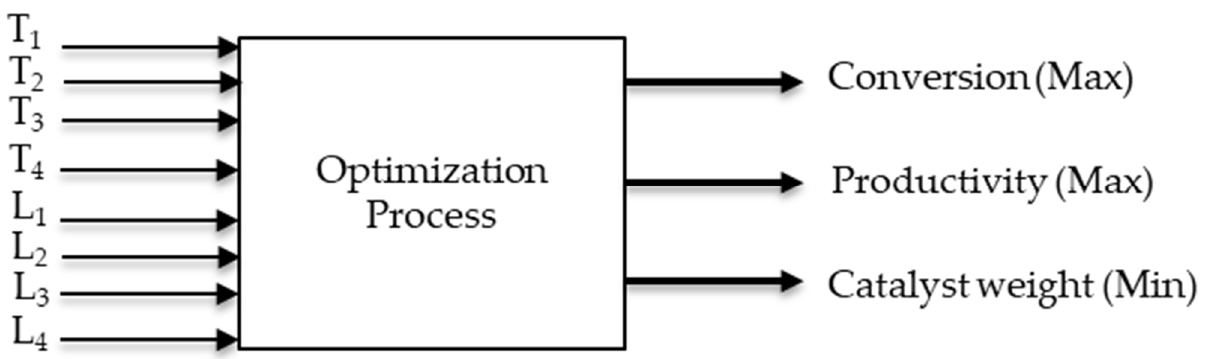
Figure 6. Schematic of the optimization of the SO 2 oxidation to SO 3 . This optimization problem considered for the scenario where four catalytic beds in series are used. The eight decision variables are the inlet temperature and the length of each catalytic bed.